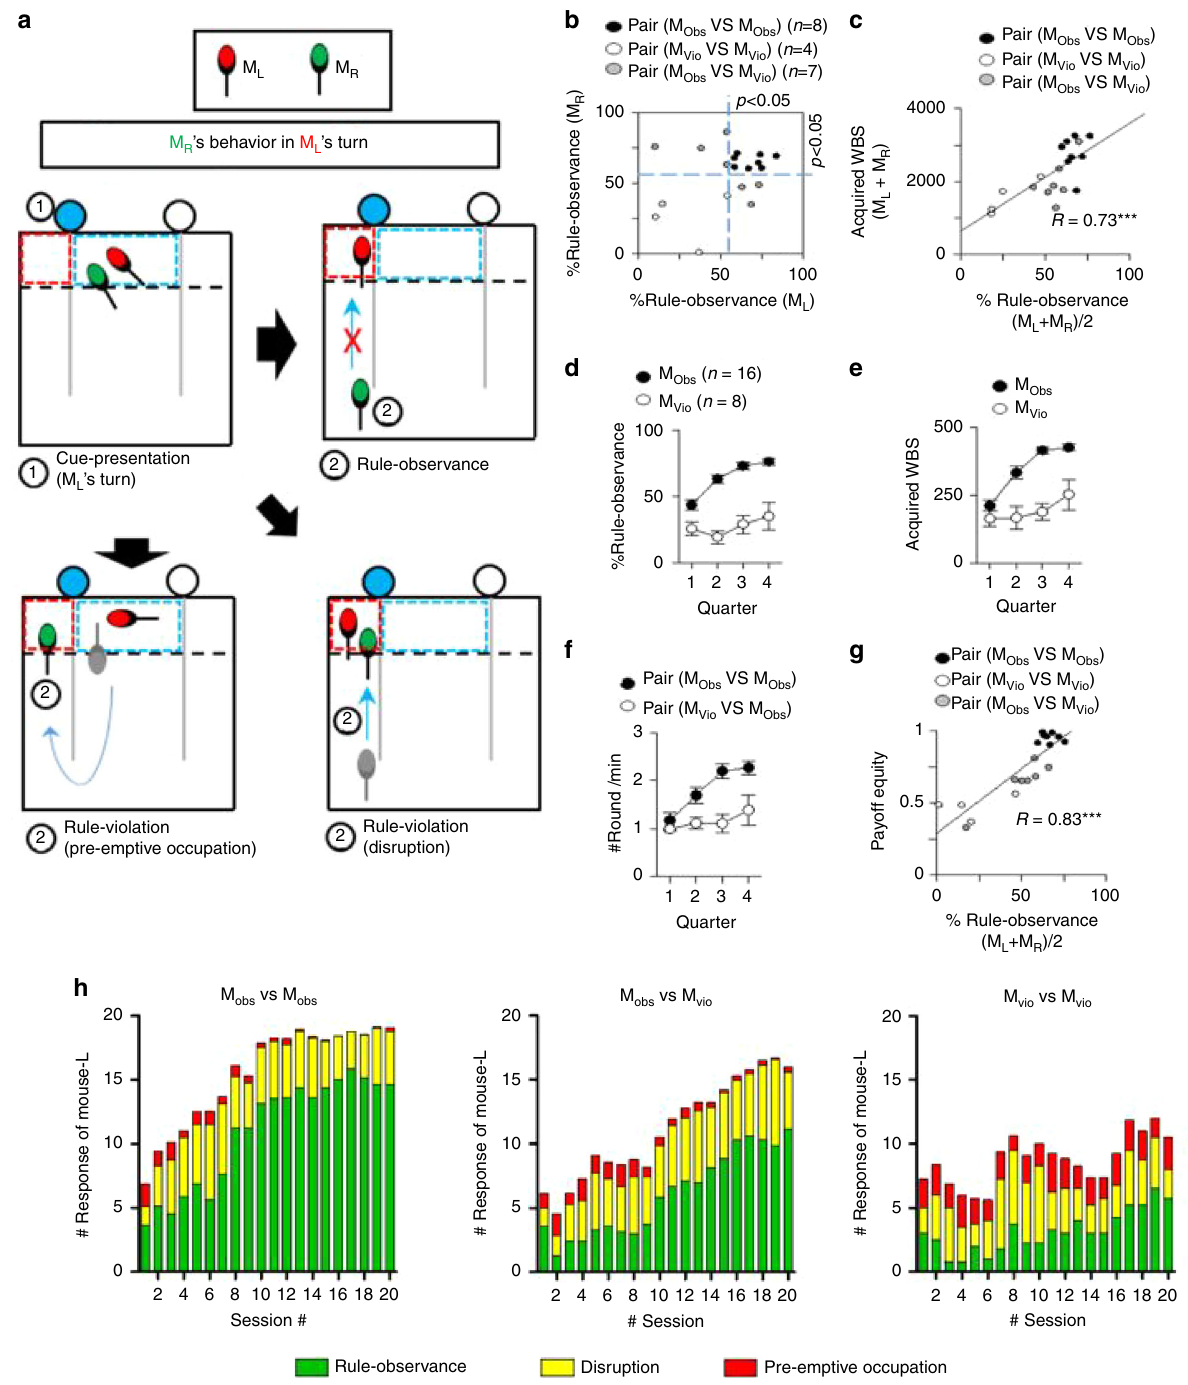
Fig. 4 Mutual rule-observance strategy enhanced long-term bene fi t and payoff equity in the WBS condition. a De fi nition of three response types of M R when the left zone was light-cued (M L ’ s turn): rule-observance, rule-violation (pre-emptive occupation) or rule-violation (disruption) behaviors. b The level of rule-observance behavior under the WBS conditions. Each dot represents % of rule-observance behavior of a pair. Blue reference lines indicates the signi fi cance level of rule-observance behavior (maximum trial number, 40; probability value, 0.5; criterion value, P < 0.05). M Obs is the mouse showing rule-observance behavior signi fi cantly and M Vio is the mouse showing rule-violation behavior. c Acquired WBS in the pair was plotted as the function of mean rule-observance of each pair. d Change in rule-observance behavior over time ( fi lled circle, for mice in the M Obs – M Obs pairs; open circle, for mice in the M Vio – M Vio pairs). M Obs in the mutual rule-observance pair (M Obs and M Obs ) increased rule-observance behavior (one-way RM analysis of variance (ANOVA), quarter, F 3, 45 = 26.4, P < 0.001) while M Vio in the mutual rule-violation pair (M Vio and M Vio ) did not. e Amount of acquired WBS was plotted over sessions: increased in M Obs (One-way RM ANOVA, quarter, F 3, 45 = 69.9, P < 0.001) but not in M Vio . f The number of rounds played per minute over sessions: increased in mutual rule-observance pairs (One-way RM ANOVA, quarter, F 3, 21 = 57.1, P < 0.001) but not in mutual rule-violation pairs. g Payoff equity plotted against mean rule-observance for each pair in the three types of pairs: positive correlation between the two is observed. (*** P < 0.001, Pearson ’ s R). h Evolution of the response type of the M L through the sessions for each of the three pair types. Green bar, rule-observance; yellow bar, rule- violation (disruption); red bar, rule-violation (pre-emptive